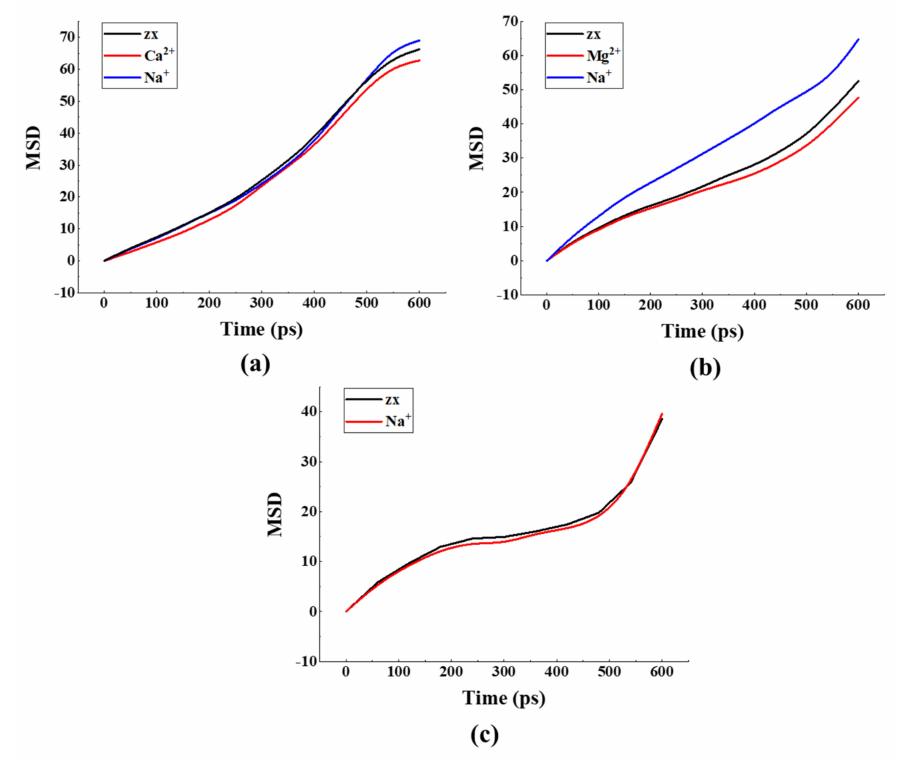
Figure 9. MSD of surfactant head groups and cations surrounding the head groups in different